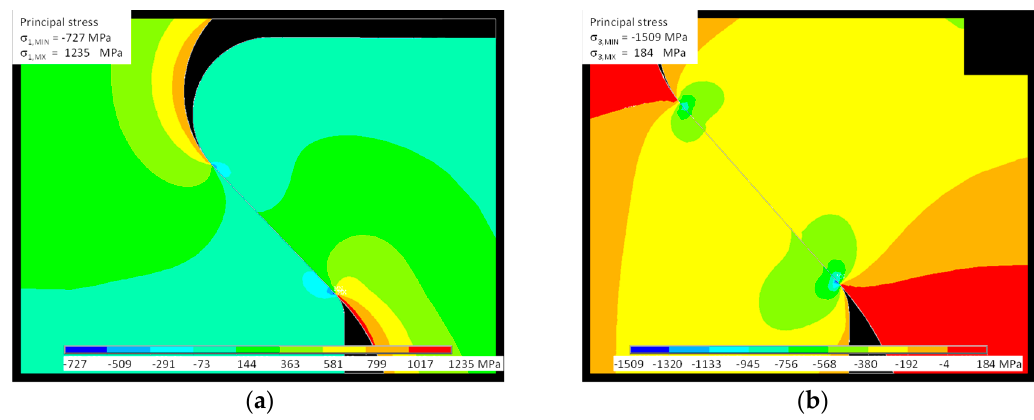
Figure 12. FE model of test # 2: ( a ) principal stress σ 1 ; ( b ) principal stress σ 3 .